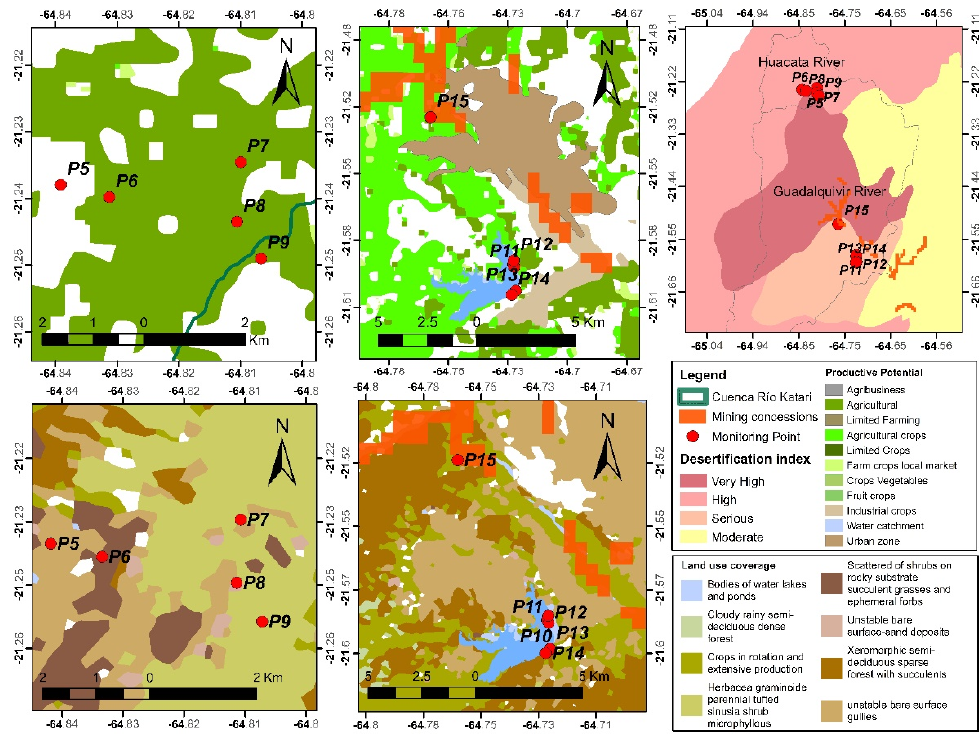
Figure 9. Identify the potential impact on water quality at the monitoring points in the Guadalquivir Figure Basin.